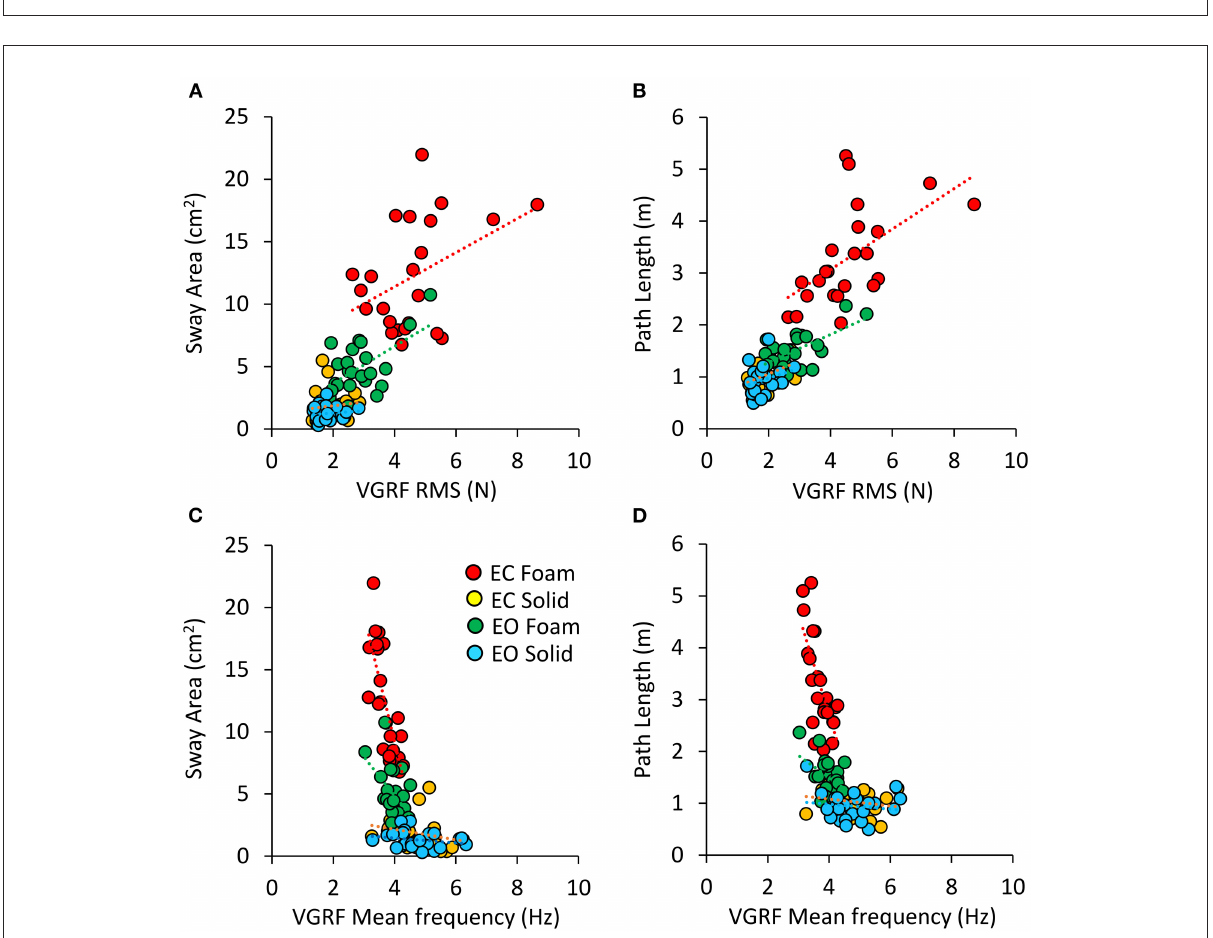
FIGURE8 Relationship between geometric measures and VGRF RMS and Mean frequency. Sway Area of each subject was plotted against the corresponding value of VGRF RMS (A) and of VGRF Mean frequency (C) . On the right, Path Length was plotted against the corresponding value of VGRF RMS (B) and VGRF Mean frequency (D) (EC Foam, red; EC Solid, yellow; EO Foam, green; EO Solid, blue). The equations of the regression lines for each variable and condition are in Tables 2,